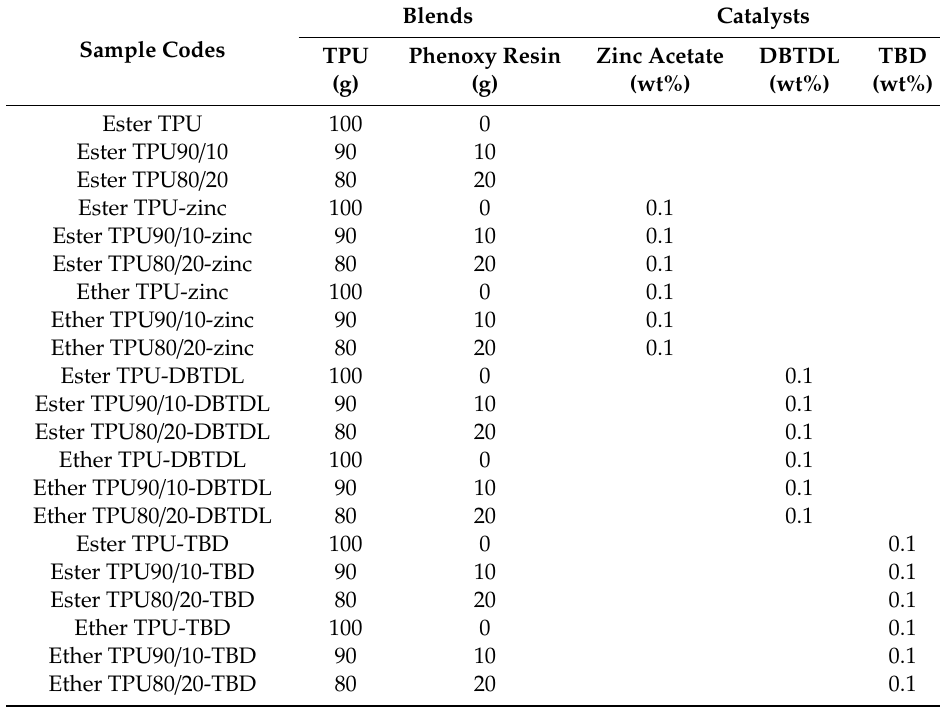
Table 1. Sample code and composition of the TPU / phenoxy resin